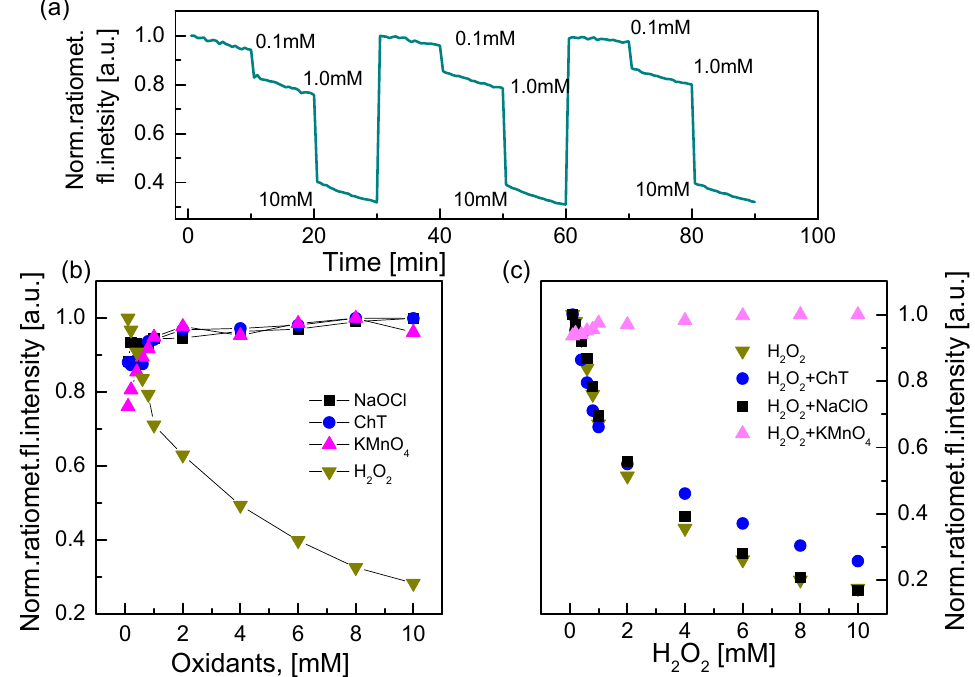
Figure 8. ( a ) Response of the HRP–QD–AF membrane with different H 2 O 2 concentrations (0.1, 1.0, 10 mM) and its reproducibility when the measurement cycle was repeated. ( b ) Response of the HRP–QD–AF membrane to different concentrations of various oxidants. ( c ) Response of the HRP–QD–AF membrane to different concentrations of H 2 O 2 and a fixed concentration of each oxidizing agent (1 mM).